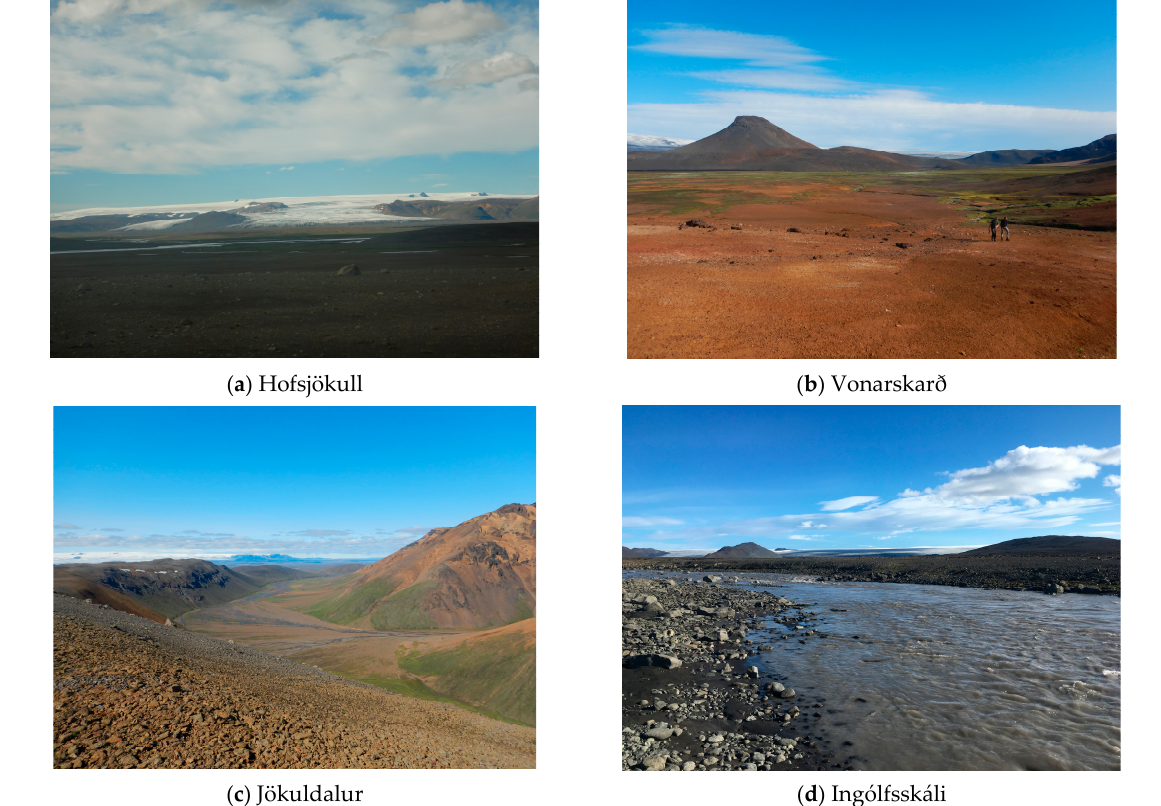
Figure 1. Map and landscapes of the Central Highlands: ( a ) Hofsjökull , ( b ) Vonarskarð , ( c ) Jökuldalur , ( d ) Ingólfsskáli .